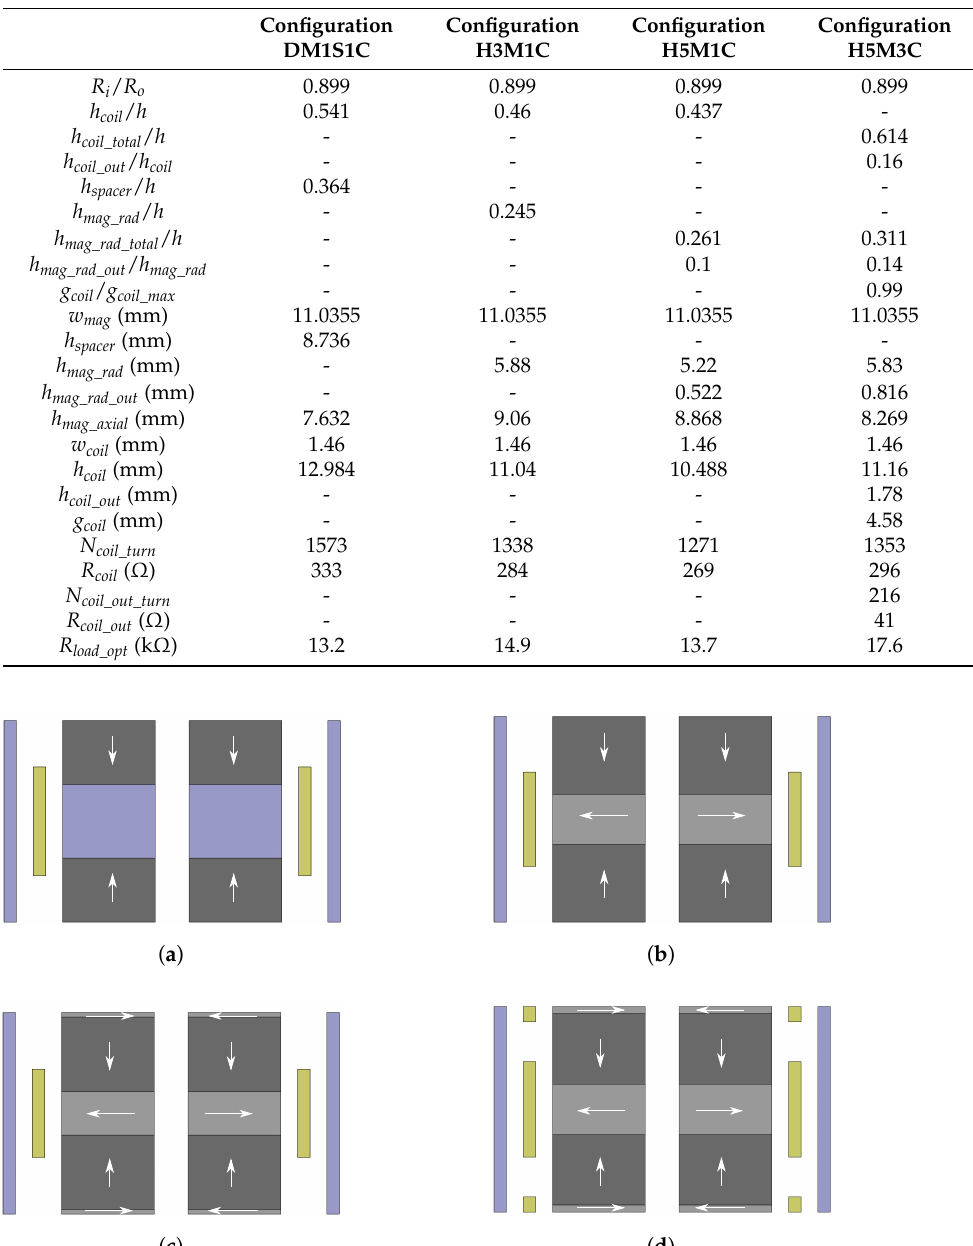
Table 6. Design parameters of the four harvester configurations after output power optimization.